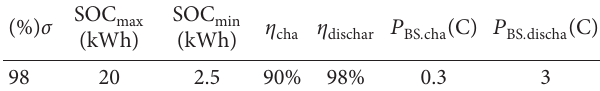
Table 4: Battery storage parameter.